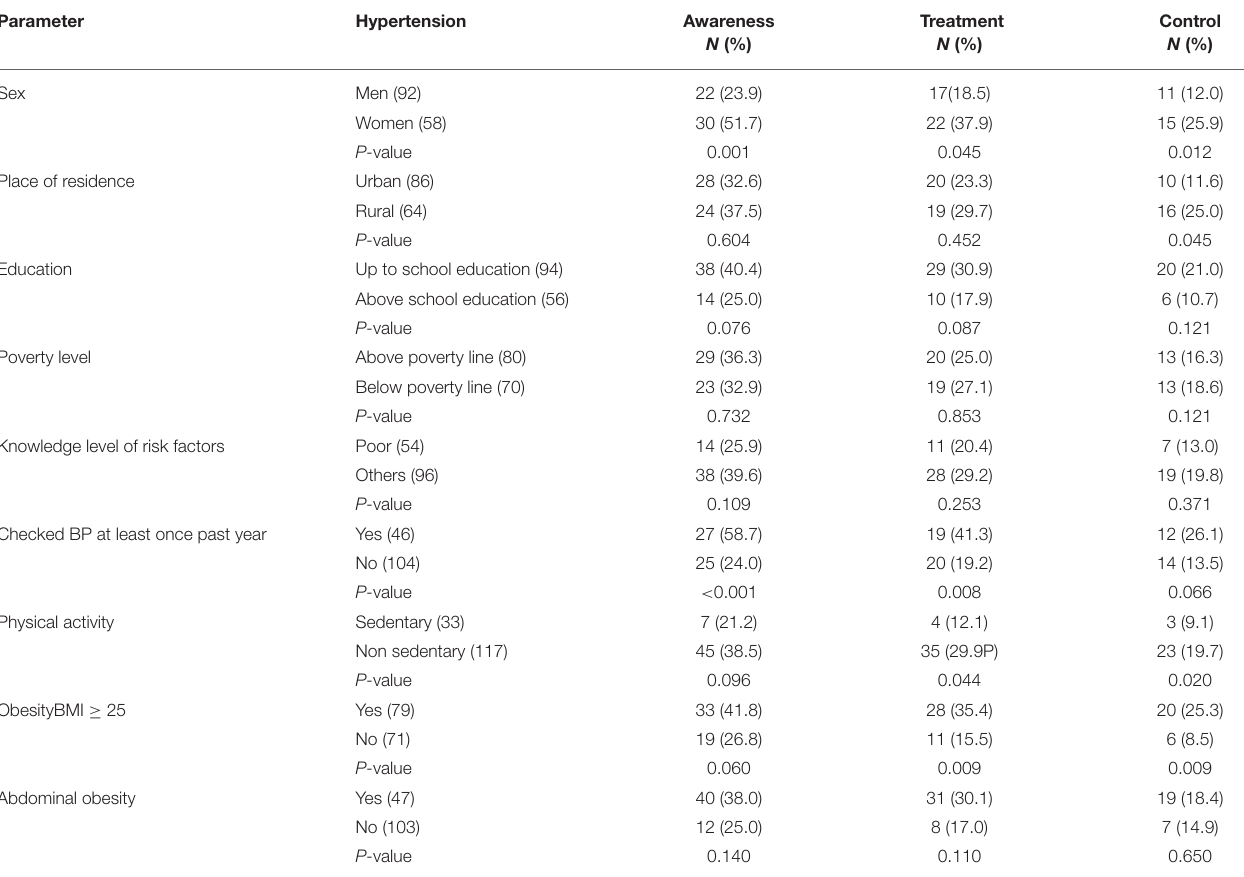
TABLE 5 | Awareness, treatment, and control of hypertension among the young adults in relation to baseline characteristics.